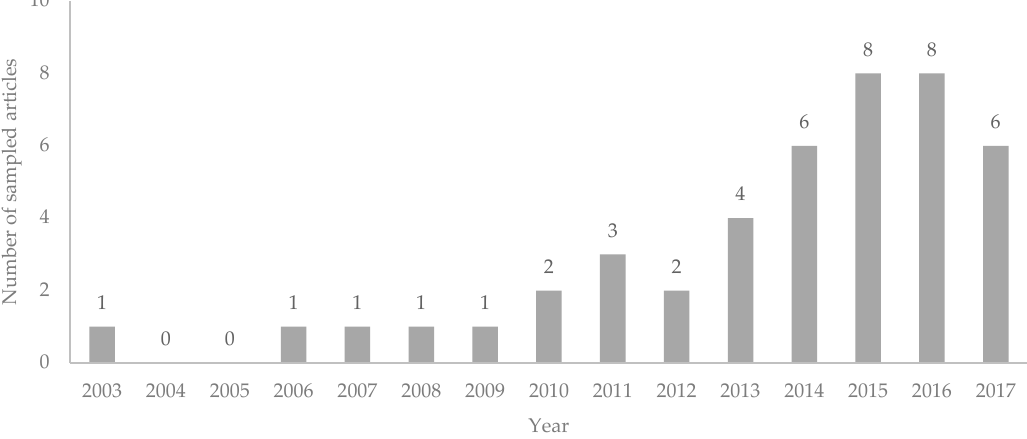
Figure 5. Number of scientific articles on energy integration in supply chain management per year.